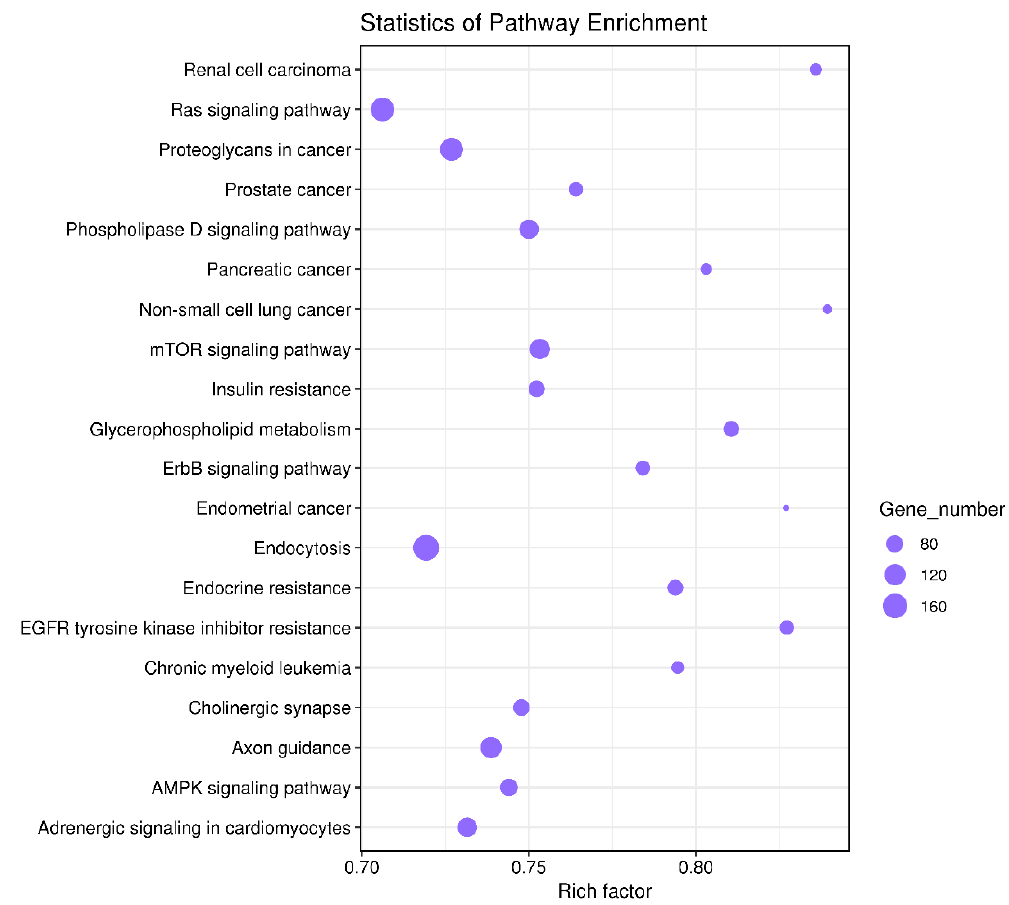
Figure 3. The top 20 signaling pathways regulated by the significantly di ff erentially expressed miRNAs. Rich factor is defined as the ratio of the number of target genes to the absolute number of genes in the pathway. The larger the factor represented, the greater the enrichment degree. The area of the spot represents the number of target genes included in the pathway.